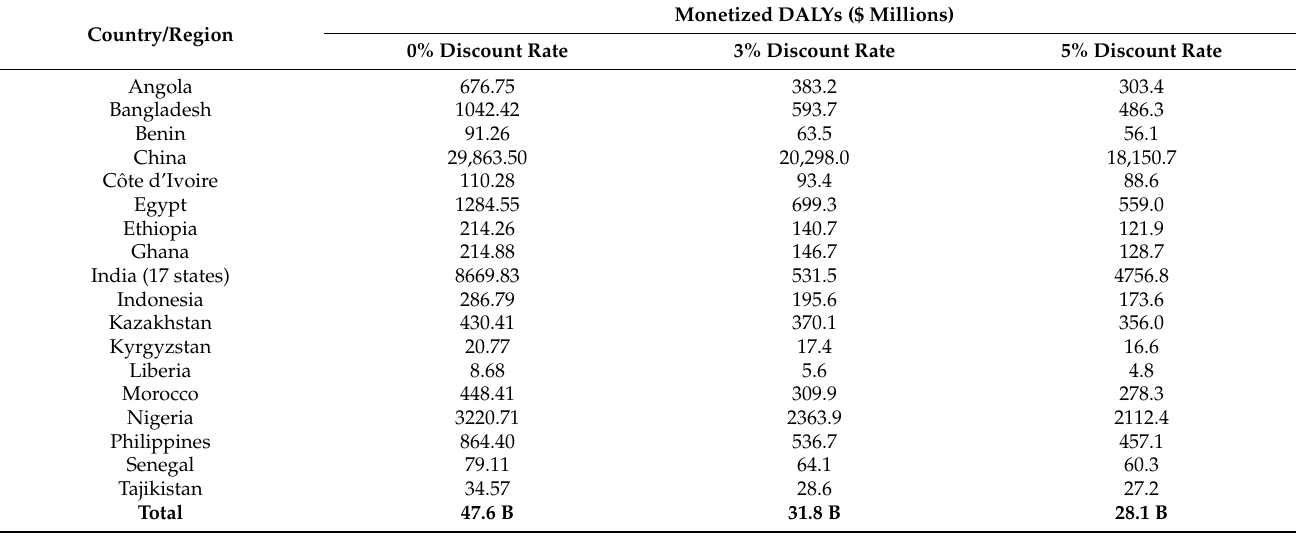
Table A2. Sensitivity analysis: monetized DALYs at 0%, 3%, and 5% discount rates at a national level. Country/Region